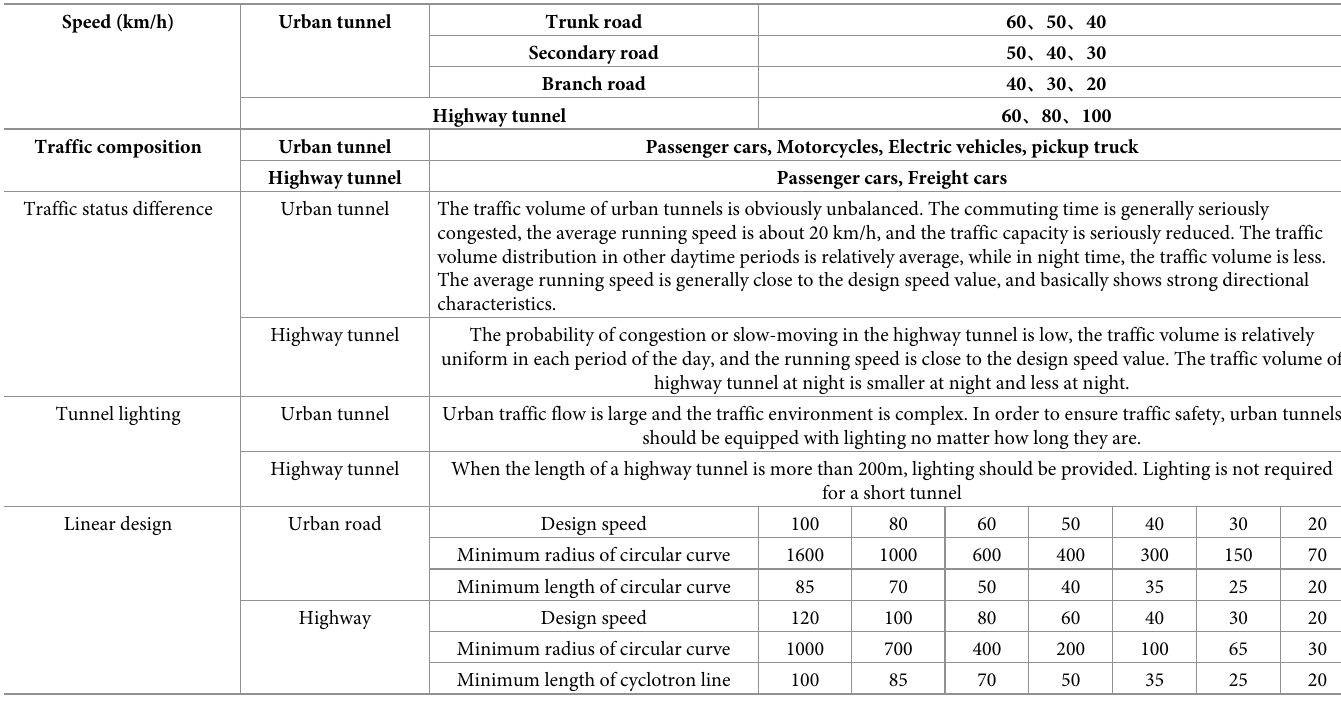
Table 1. Statistical difference between highway tunnel and urban